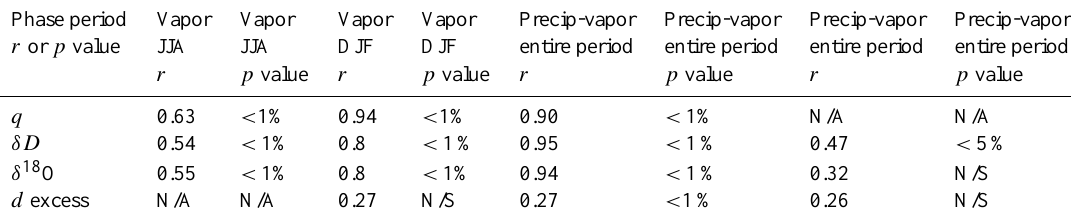
Table 5. Daily correlation coefficient ( r ) and its significance ( p value) between observations at Kourovka and LMDZ simulation results for humidity ( q ), water vapor δD , δ 18 O, d excess and differences of these variables between precipitation and water vapor. During the December- January-February (DJF) season, data is available only for December. If the p value is lower than 5%, we assume that the correlation coefficient is statistically significant. N/S means “not